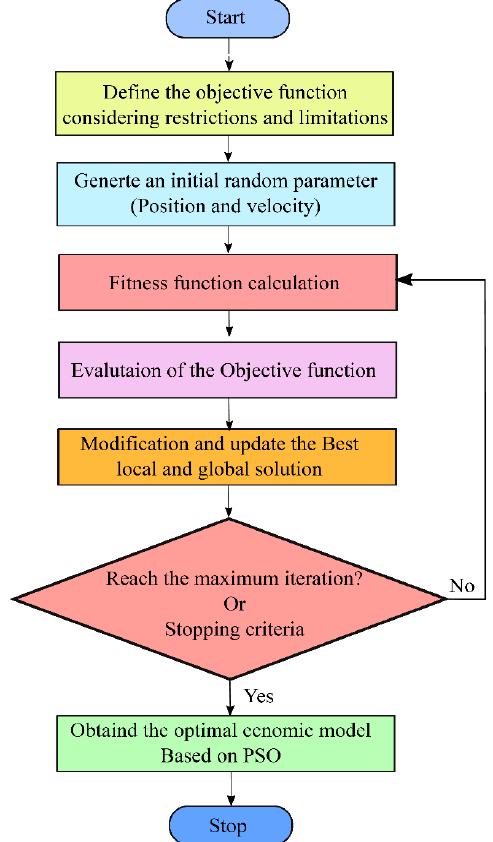
Figure 1 . Flowchart of PSO algorithm